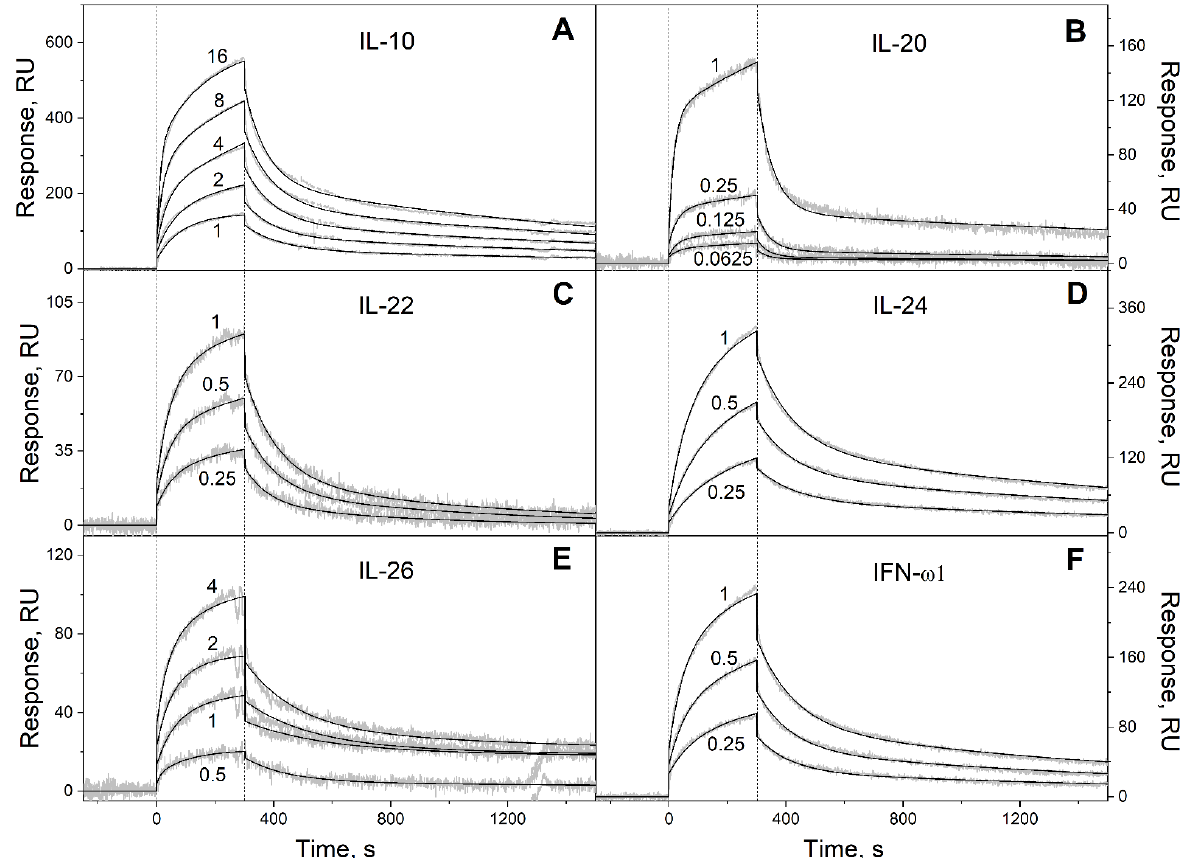
Figure 3. Kinetics of the interaction of Ca 2+ -loaded S100P with specific four-helical cytokines of Interferons/IL-10 family shown in Table 2 at 25 °C, monitored by SPR spectroscopy using S100P as an analyte and the cytokines as a ligand immobilized on the sensor chip surface by amine coupling. ( A ): IL-10; ( B ): IL-20; ( C ): IL-22; ( D ): IL-24; ( E ): IL-26; ( F ): IFN- ω 1. Buffer conditions: 10 mM HEPES, 150 mM NaCl, 1 mM CaCl 2 , 0.05% TWEEN 20, pH 7.4. The vertical dotted lines mark the association phase, followed by the dissociation phase. Molar analyte concentrations (µM) are indicated for the sensograms. The gray curves are experimental, while the black curves are theoretical, calculated according to the heterogeneous ligand model (1) (see Table 3). Table 3. Parameters of the heterogeneous ligand model (1), describing the SPR data on kinetics of interaction between Ca 2+ -loaded S100P and specific four-helical cytokines shown in Table 2 at 25 °C (see Figures 1–3).